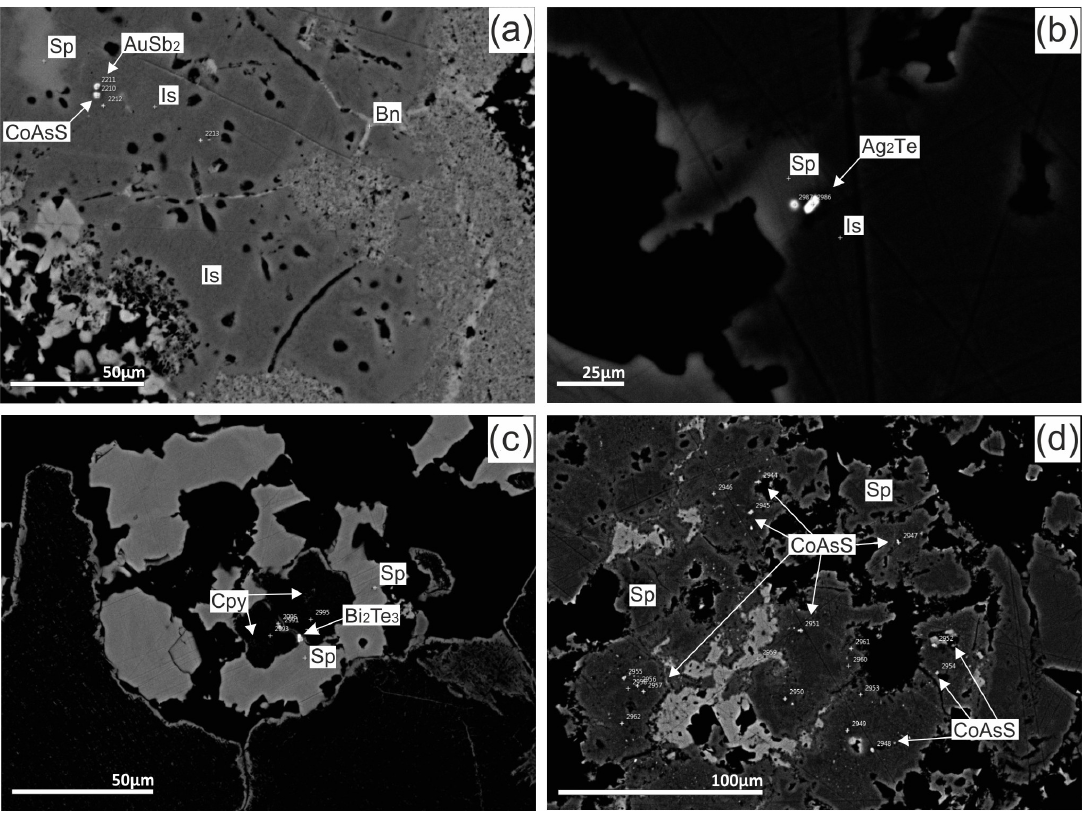
Figure 11. Au and Te minerals of sphalerite-wurtzite-chalcopyrite-isocubanite breccias with opal cement. BSE photographs. ( a ) Aurostibite (AuSb 2 ) and cobaltite (CoAsS) in the isocubanite-sphalerite aggregates; ( b ) Hessite (Ag 2 Te) at the boundary of sphalerite-isocubanite aggregates; ( c ) Rare grains of tellurobismuthite (Bi 2 Te 3 ) associated with the unaltered zone of chalcopyrite grains; ( d ) A large amount of cobaltite in the secondary